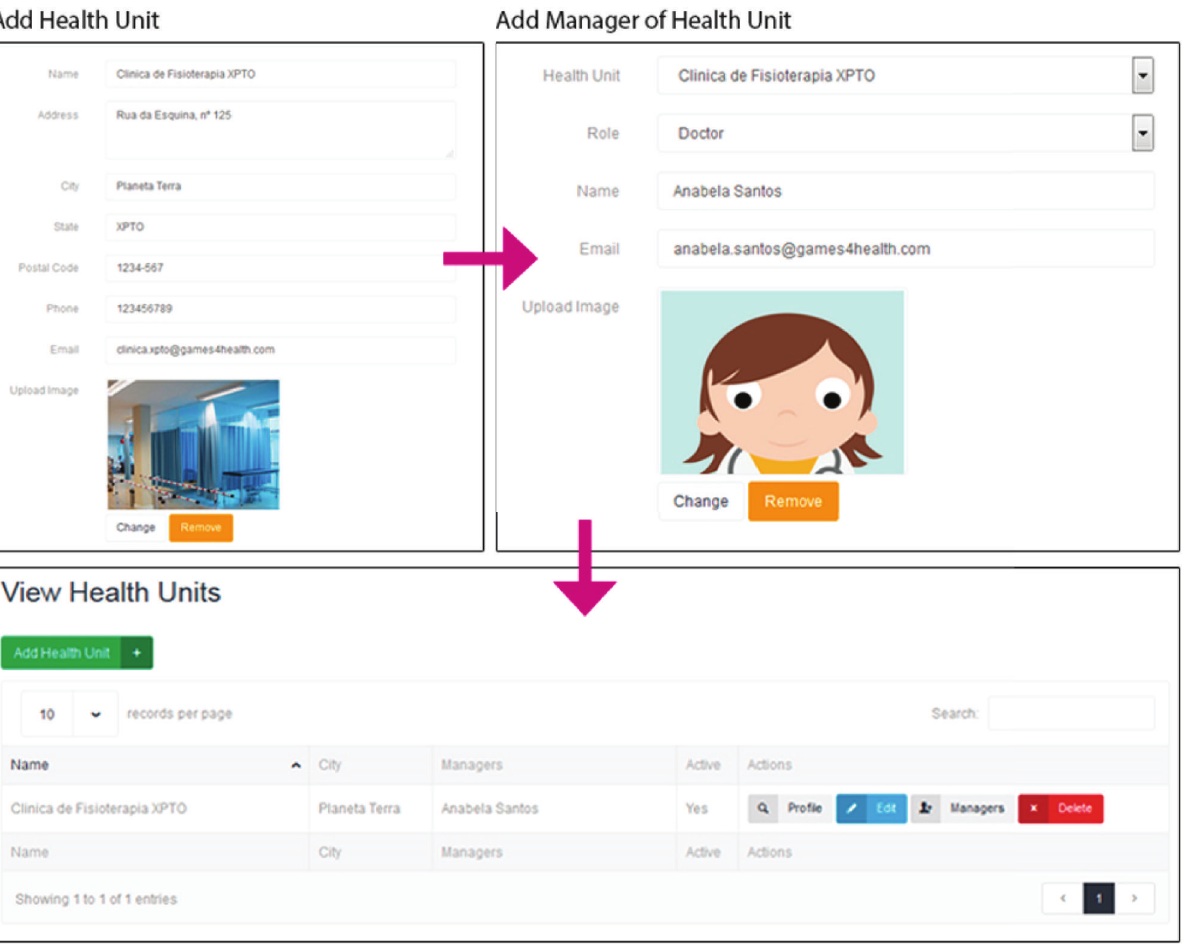
Figure 7: Creating process of a Health Unit.